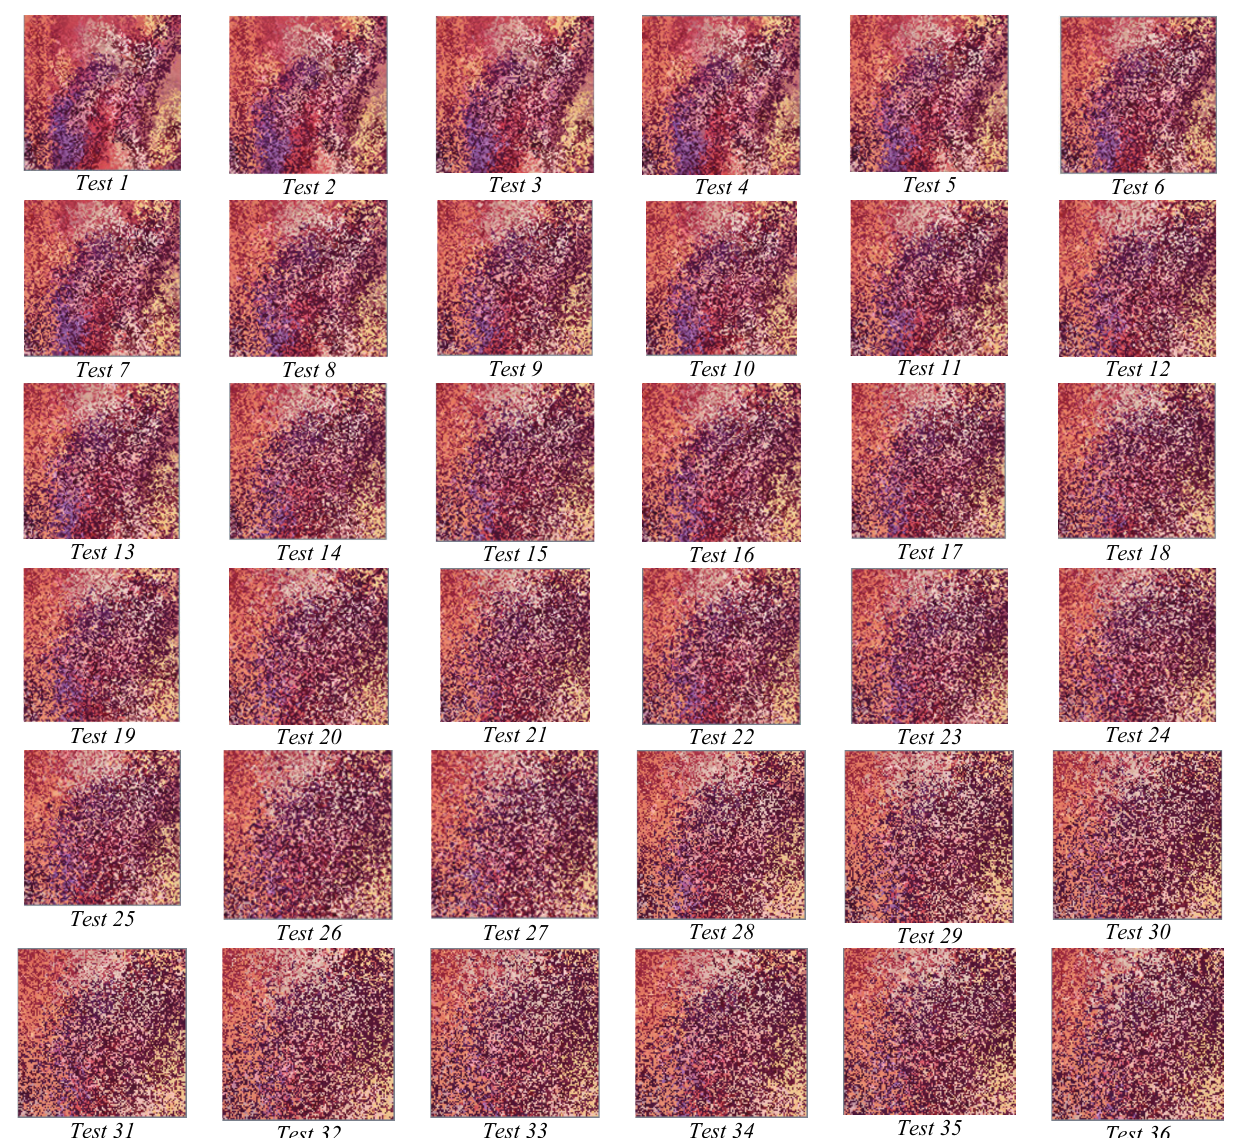
Fig. 4. Ciphering images obtained by S2CA for different parameter